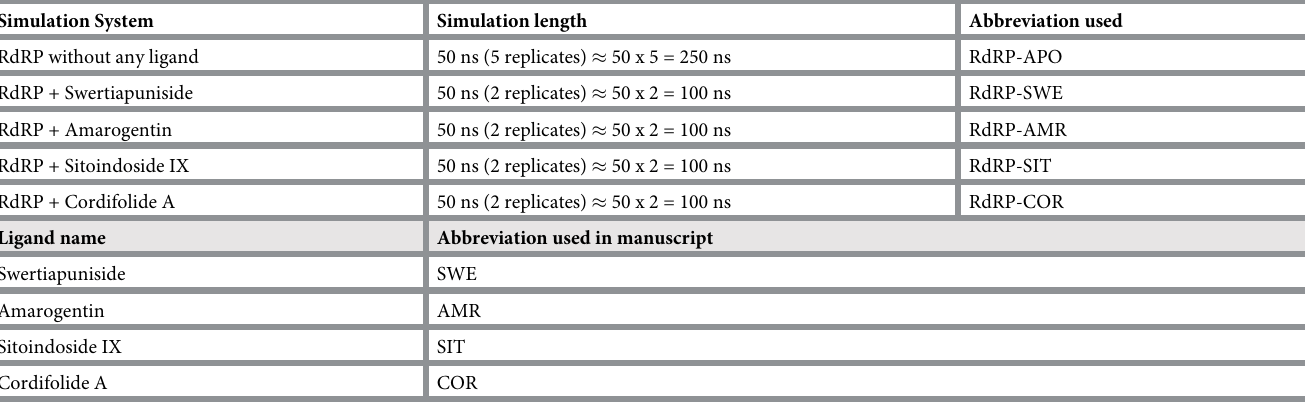
Table 3. Information about the simulations and abbreviation